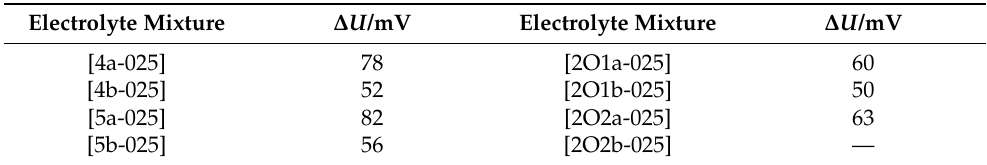
Table 8. Overpotential of charging vs. discharging plateau during the first cycle at C/50 in LFP/LTO cells at room temperature ( T = 298 ◦ C). Electrolyte